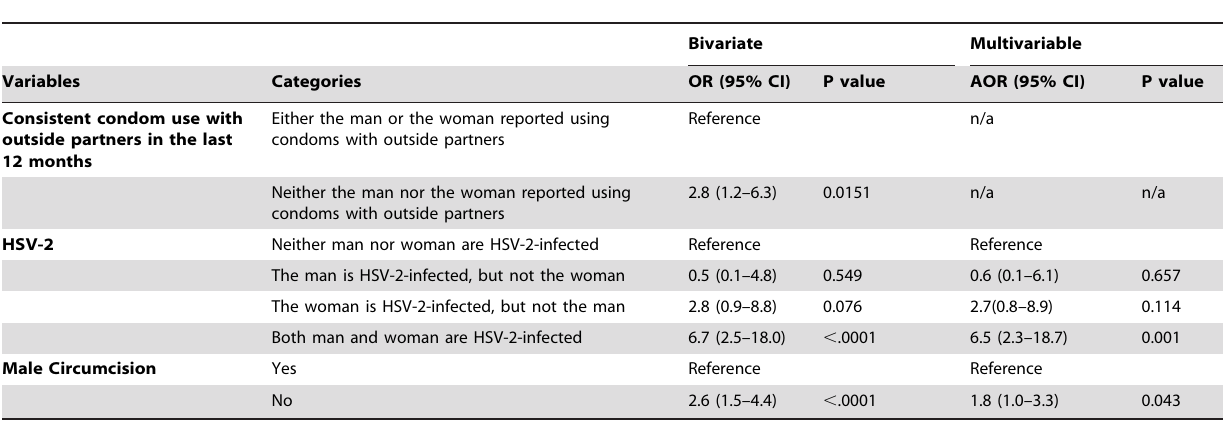
*Table includes all variables that were significantly associated with HIV-infected concordance vs. HIV discordance in the bivariate analysis. doi:10.1371/journal.pone.0017842.t003 PLoS ONE |